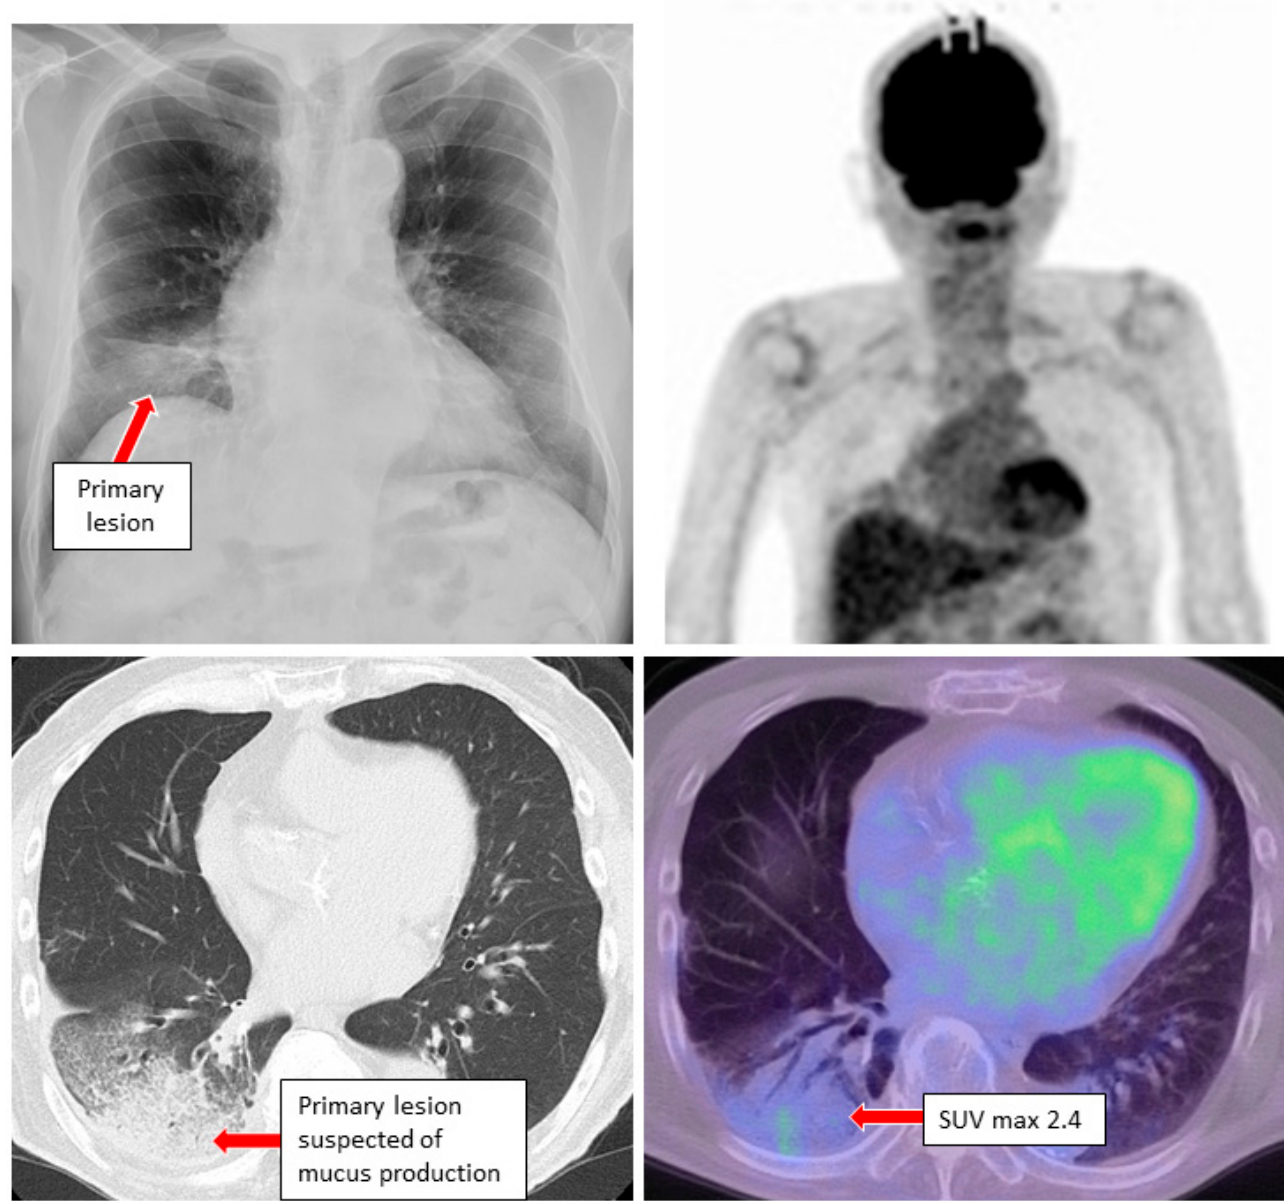
Figure 7. Chest X-ray, CT and FDG-PET examinations in case 3 revealed primary lung cancer at the right lower lobe. CT: computed tomography, FDG-PET: 18F-2-fluoro-2-deoxy-D-glucose-positron emission tomography.